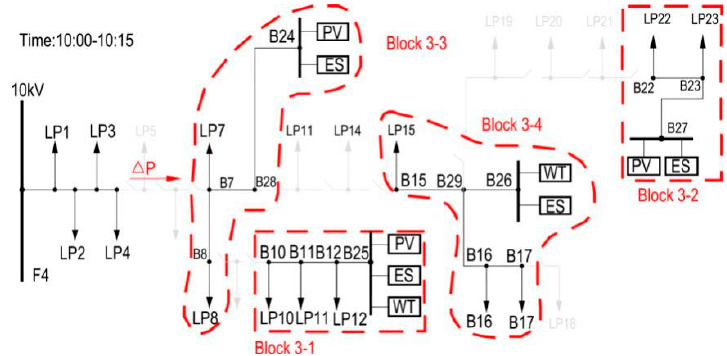
Figure 6. 9:00–9:15 division of decision-making body.